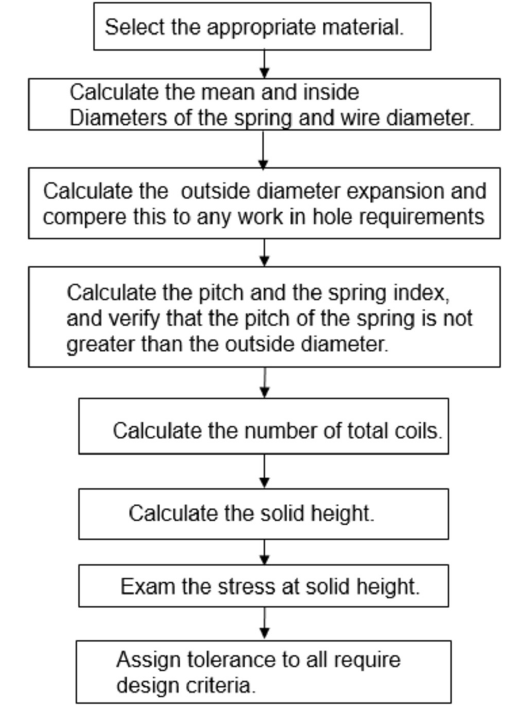
Figure 14. The basic spring design